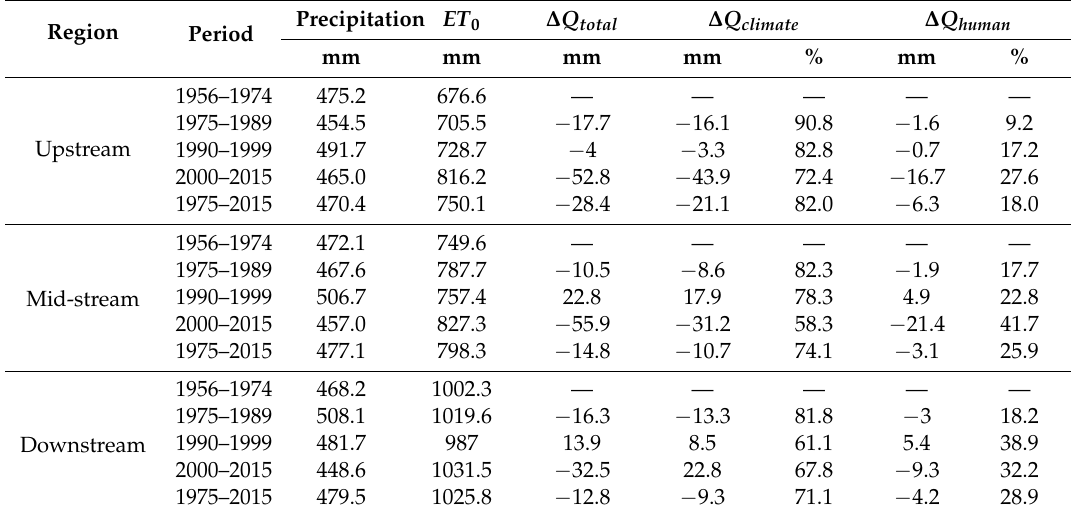
Table 3. The effect of climate change and human activities on